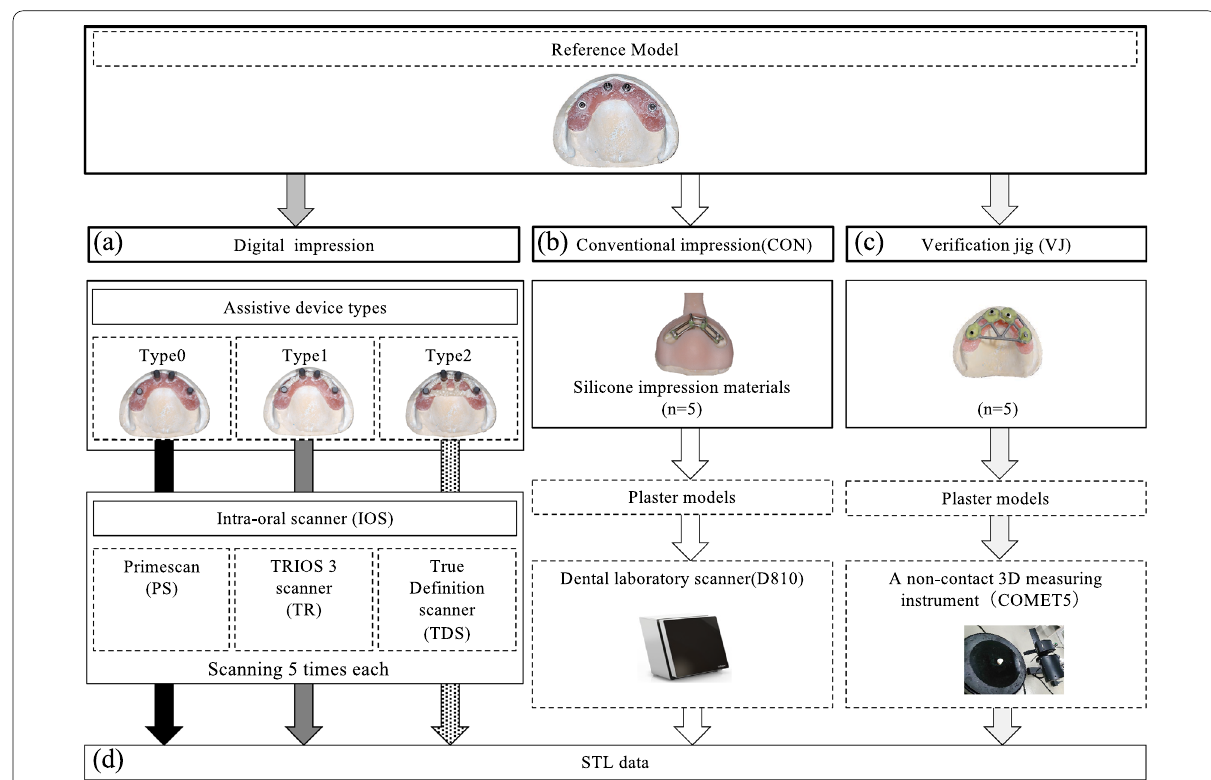
Fig. 3 Graphical representation of the overall workflow of this study. a Digital impressions were taken five times by all the intraoral scanners in each type. b Five conventional impressions with silicone impression materials were obtained, and working casts were fabricated. Five plaster models were scanned by a dental laboratory scanner, and STL datasets were generated. c The impression copings were connected to the reference model, and the plaster model was removed after the verification jig was fixed with self-curing acrylic resin. Five plaster models were scanned by a non-contact 3D measuring instrument, and STL datasets were generated. d All STL data sets obtained from each group were trimmed and confined to the images of the scan